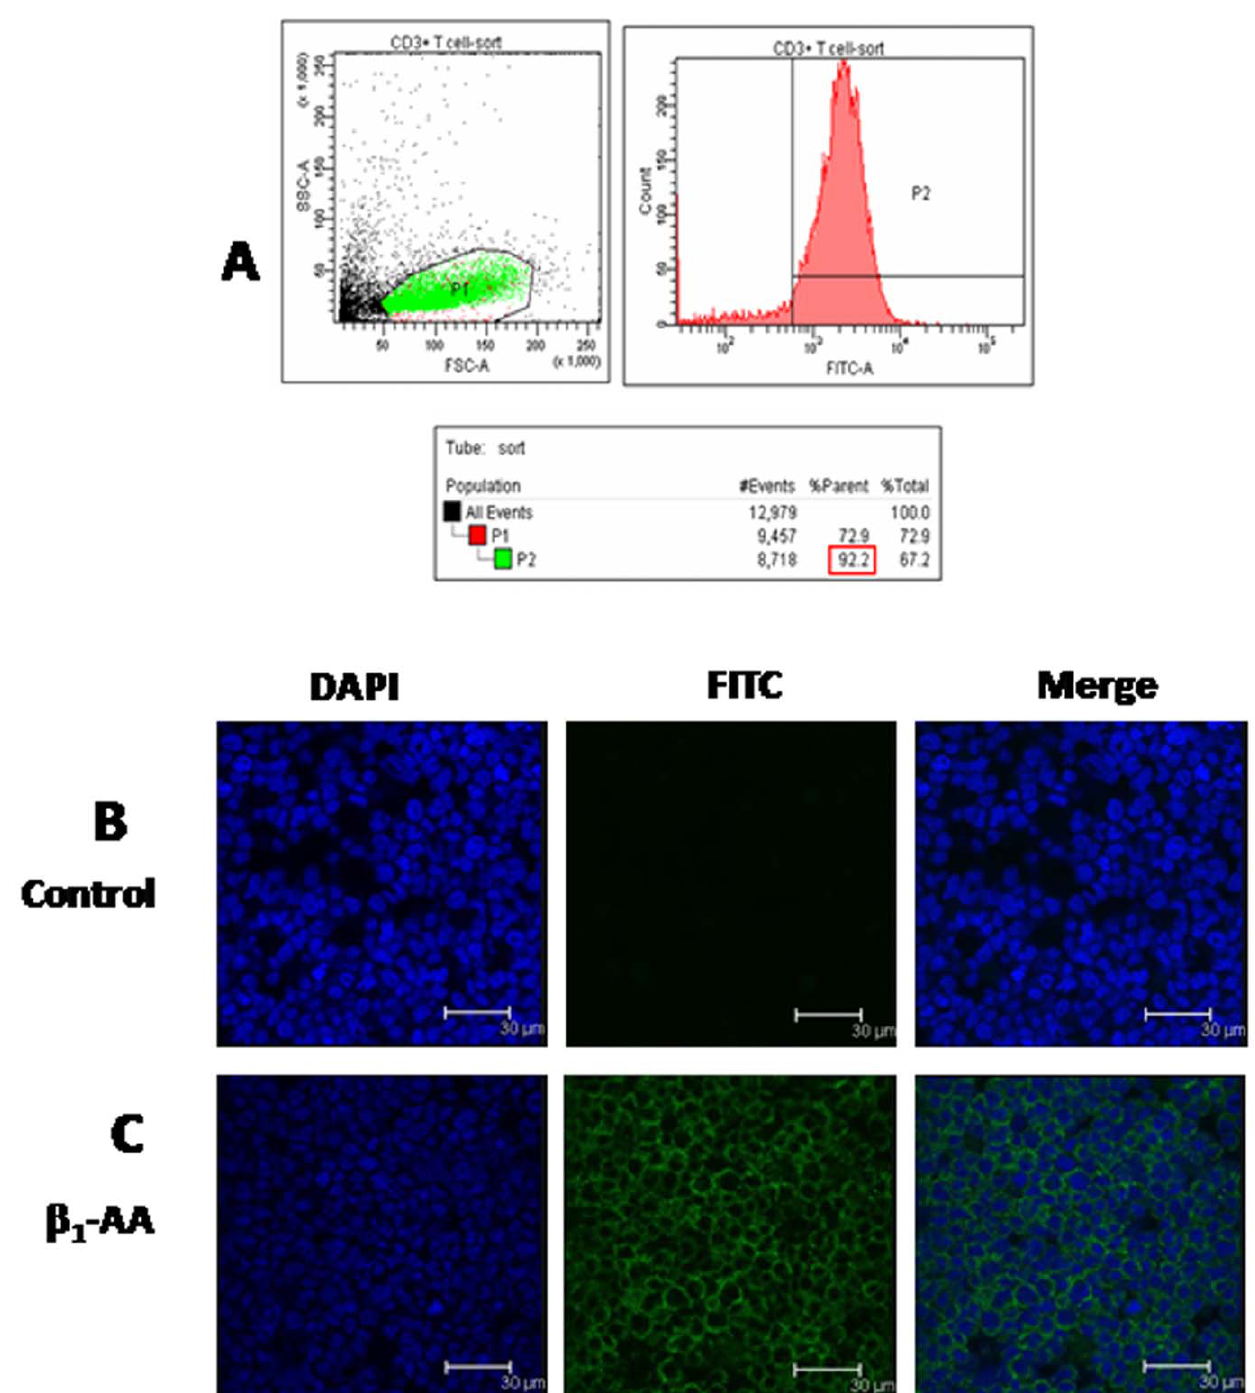
Figure 2. b 1 -AA from DCM patients bound to b 1 -ARs on the surface of CD3 + T cells. A. After FACS, the purity of selected rat CD3 + T lymphocytes by immunomagnetic separation was 92.2%. B, C. The binding of b 1 -AA (25 m g/ml) with the b 1 -ARs on the CD3 + T cells was determined by confocal microscopy, and b 1 -AR was identified using an anti- b 1 -AR antibody (green). Nuclei were labeled with DAPI (blue). The negative control was performed by omitting primary antibodies during the incubation. Bar, 30 m m. doi:10.1371/journal.pone.0052911.g002 the presence of b 1 -AA in the sera of DCM patients showed a time- techniques, we could demonstrate that b 1 -AA isolated from DCM course decrease, and the different pathological processes of heart patients recognized b 1 -ARs expressed either on CD3 + T cells or on H9c2 rat cardiomyoblast cells transiently transfected with b 1 -AR failure patients could lead to the changes of incidence of b 1 -AA. Moreover, using the immunofluorescence and radioligand-binding (Fig. S1C, Fig. 2), whereas after b 2 -ARs expressed on CD3 + T cells